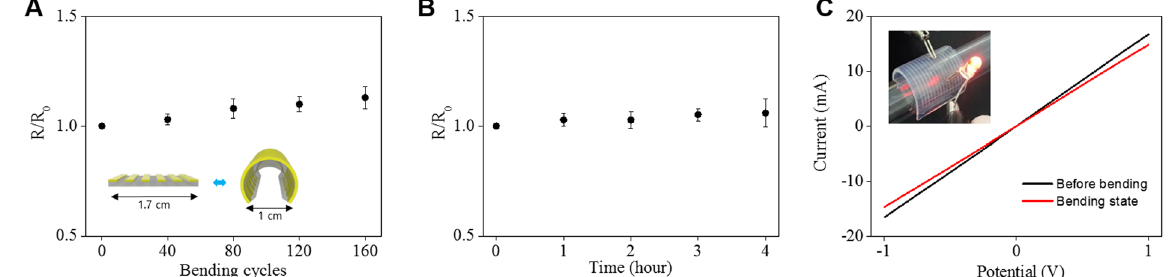
Figure 5. Mechanical flexibility or stability of AgNW-based micropatterns was measured by digital multi-tester device and compared to the initial value. ( A ) Bending test of AgNW-based micropatterns (700 μ m in width and 2 cm in length) on PEG hydrogel. ( B ) Stability test of AgNW-based micropatterns on PEG hydrogel in DI water. ( C ) The I–V performance of the AgNW-micropatterns (500 μ m in width, 2 cm in length) on hydrogel before bending and in bending state. The inset shows the LED emission with flexible AgNW-based micropatterns (500 μ m in width and 2 cm in length) on agarose